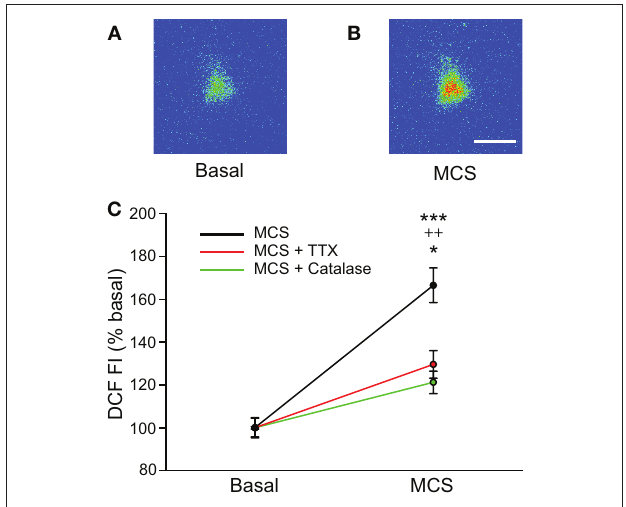
FiGuRe 2 | Glutathione (GSH) peroxidase inhibition increases levels of endogenously produced H O in SNr GABAergic neurons. (A) Pseudocolored 2 2 photomicrograph of basal DCF fluorescence in a SNr GABAergic neuron. (B) DCF fluorescence intensity (FI) increased following inhibition of GSH peroxidase with mercaptosuccinate (MCS; 1 mM). Scale bar = 20 μm. (C) Plot of the DCF FI increase caused by MCS alone (black), by MCS in the presence of catalase (500 U/mL; green), and by MCS in the presence of TTX (2 μM; red). The MCS-induced increase in DCF FI was strongly attenuated when MCS was applied in the presence of catalase as well as when spontaneous activity was silenced with TTX when measured at the same duration of MCS exposure. These data indicate that GSH peroxidase inhibition by MCS increases intracellular H O 2 2 concentration in SNr neurons and that spontaneous activity contributes to endogenous